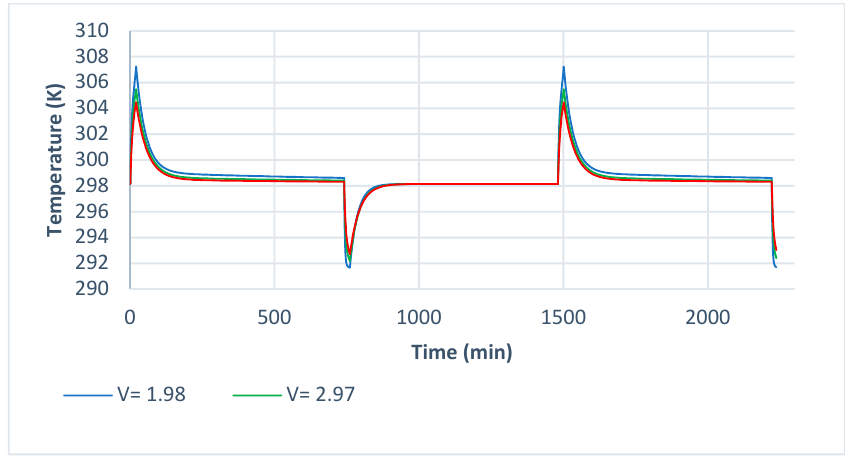
Figure 9. Gas temperature trend for the Second Configuration varying the Volume of the tank.